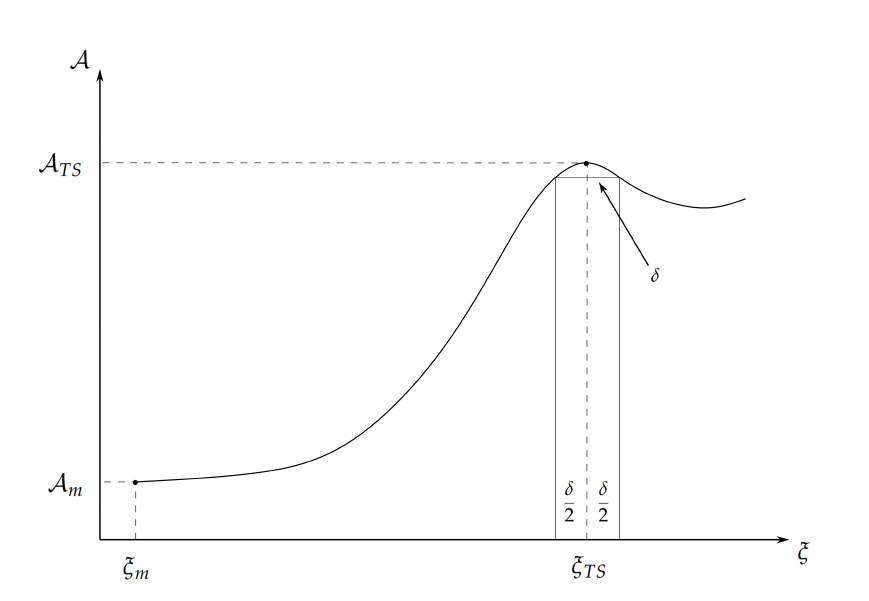
Figure 1. Pictorial representation of a generic free energy profile along the reaction coordinate ξ